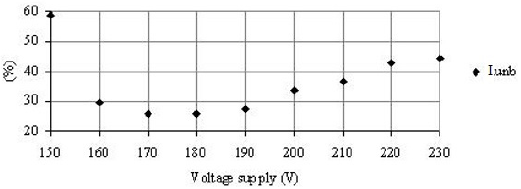
Figure 5. Unbalance factor for currents I unb depending on the supply voltages (set 1).